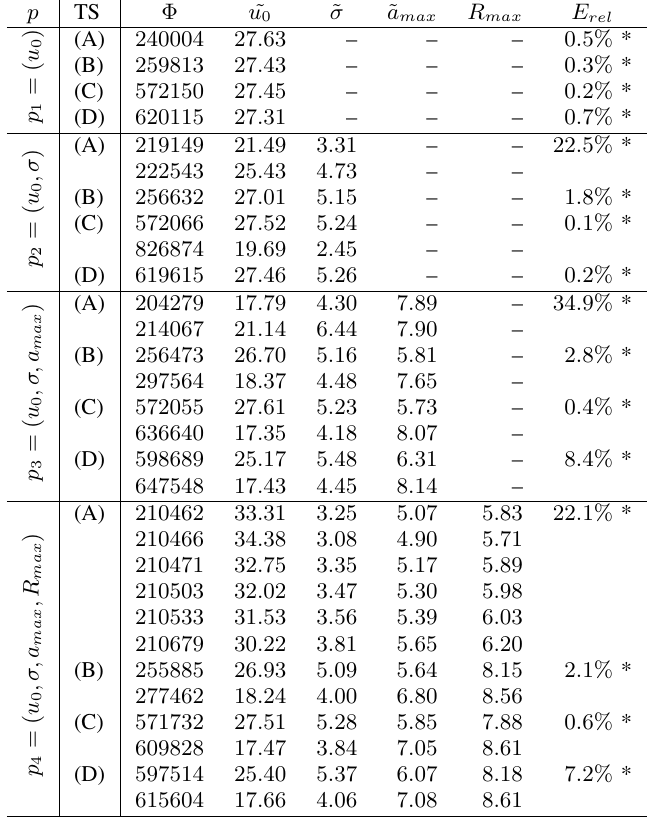
L OCAL MIMIMA OF THE OBJECTIVE FUNCTION Φ , WITH THE FOUR SETTINGS OF TRAPS WITH RESPECT TO THE NUMBER OF PARAMETERS ESTIMATED SIMULTANEOUSLY . TS STANDS FOR THE TRAP SETTING USED (F IG . 2). T HE * INDICATES THE SET OF PARAMETERS IDENTIFIED AS THE GLOBAL MINIMIZER OF Φ